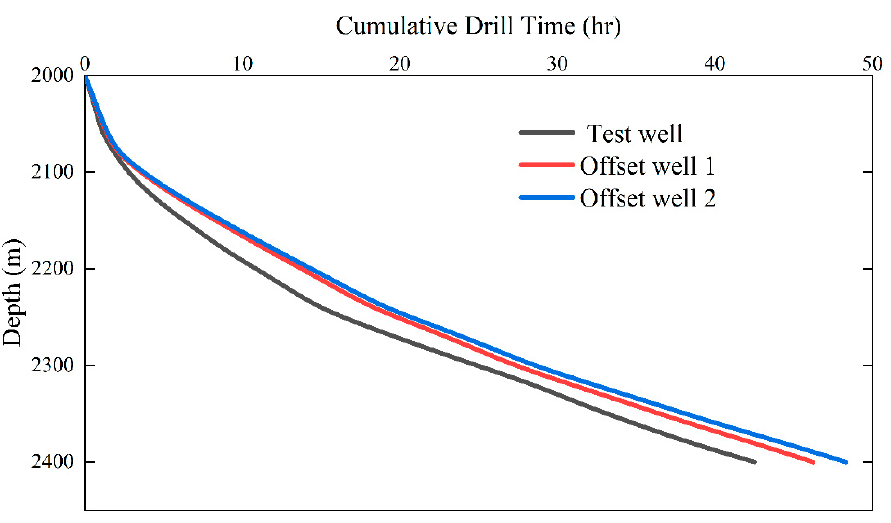
Figure 8. Drilling hours vs. depth.